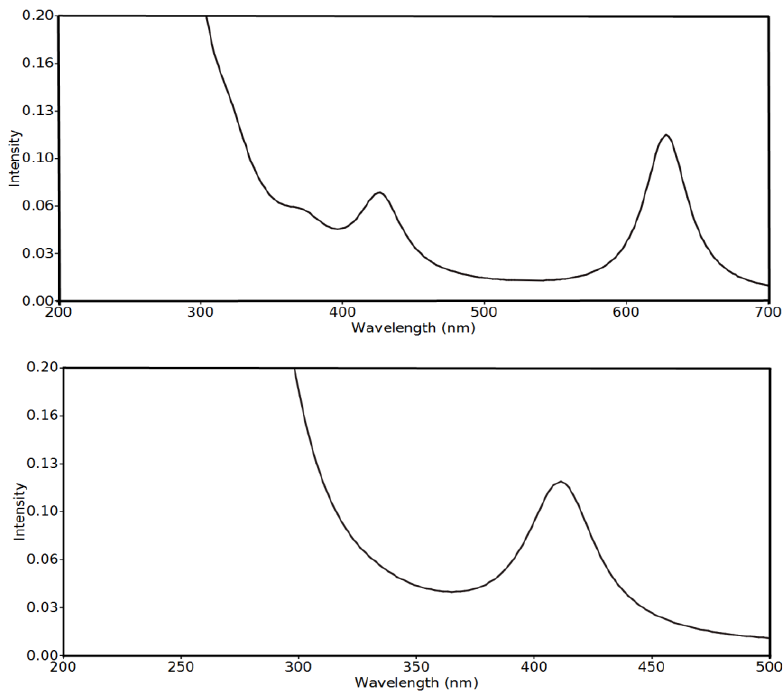
Figure 13. The calculated electronic spectra of the AMFP–DDQ (upper) and AMFP–TCNE (lower) CT complexes.